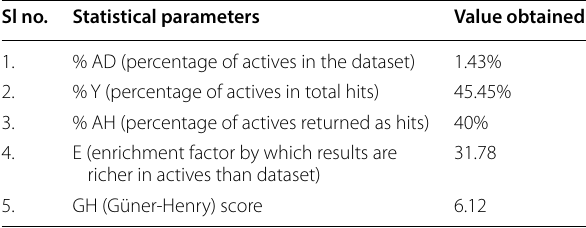
Table 2 Statistical parameters of pharmacophore study